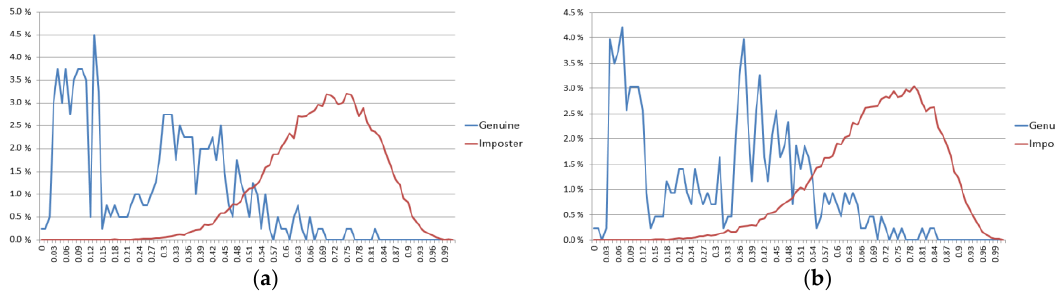
Figure 12. Graphical representations of clients (genuine) and imposters with testing data of the NICE.II dataset. ( a ) First fold cross-validation; ( b ) second fold cross-validation.